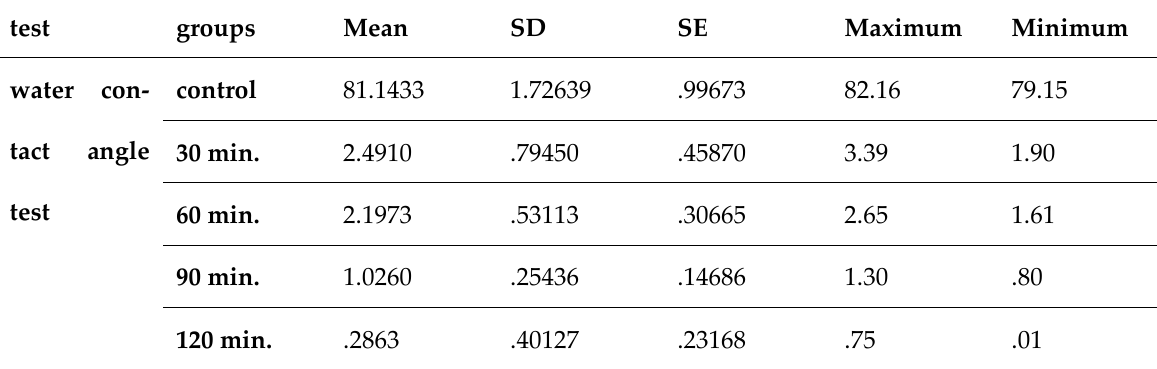
Table 2: Descriptive statistic of water contact angle test